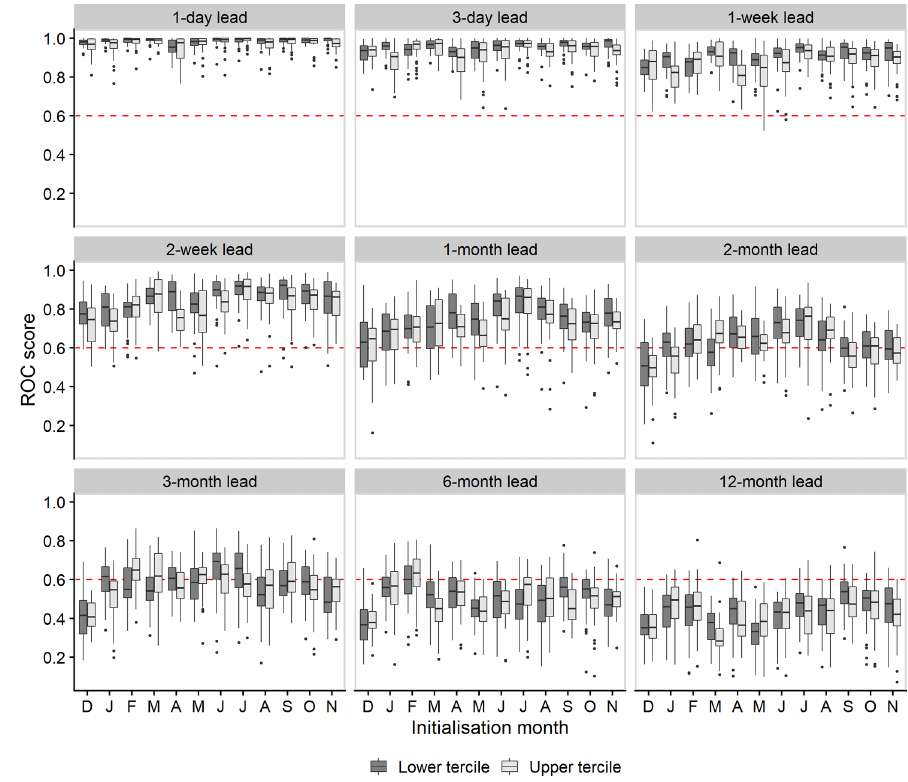
Figure 9. As in Fig. 8 but for the ROC score. The red line denotes the stricter skill threshold of